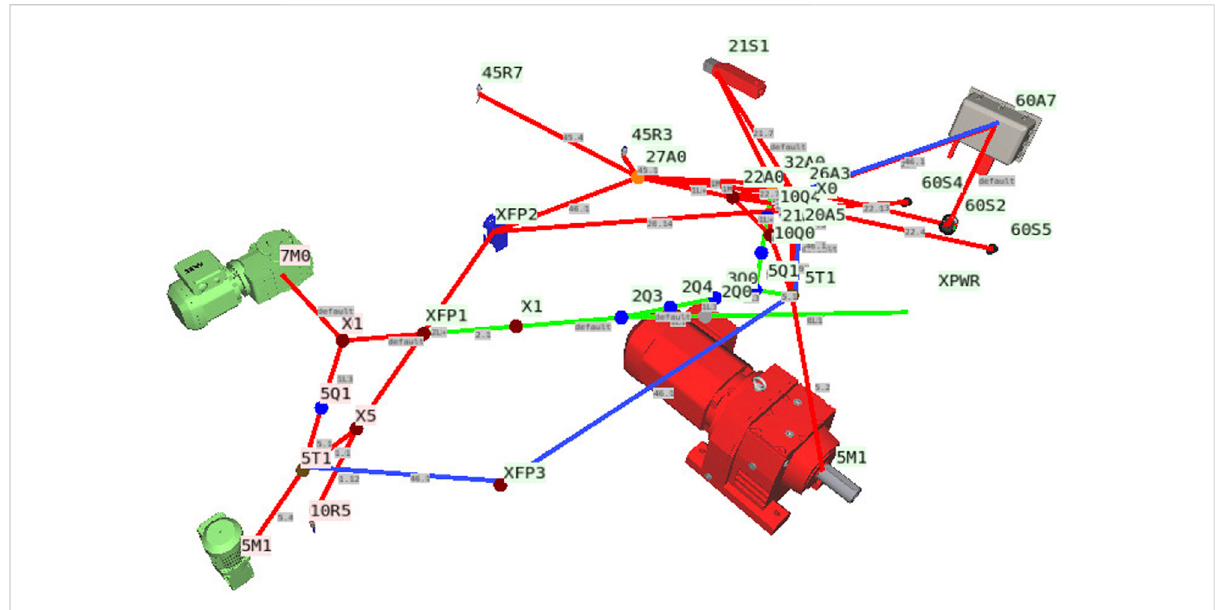
FIGURE 9 Wiring graph and electrical components of the